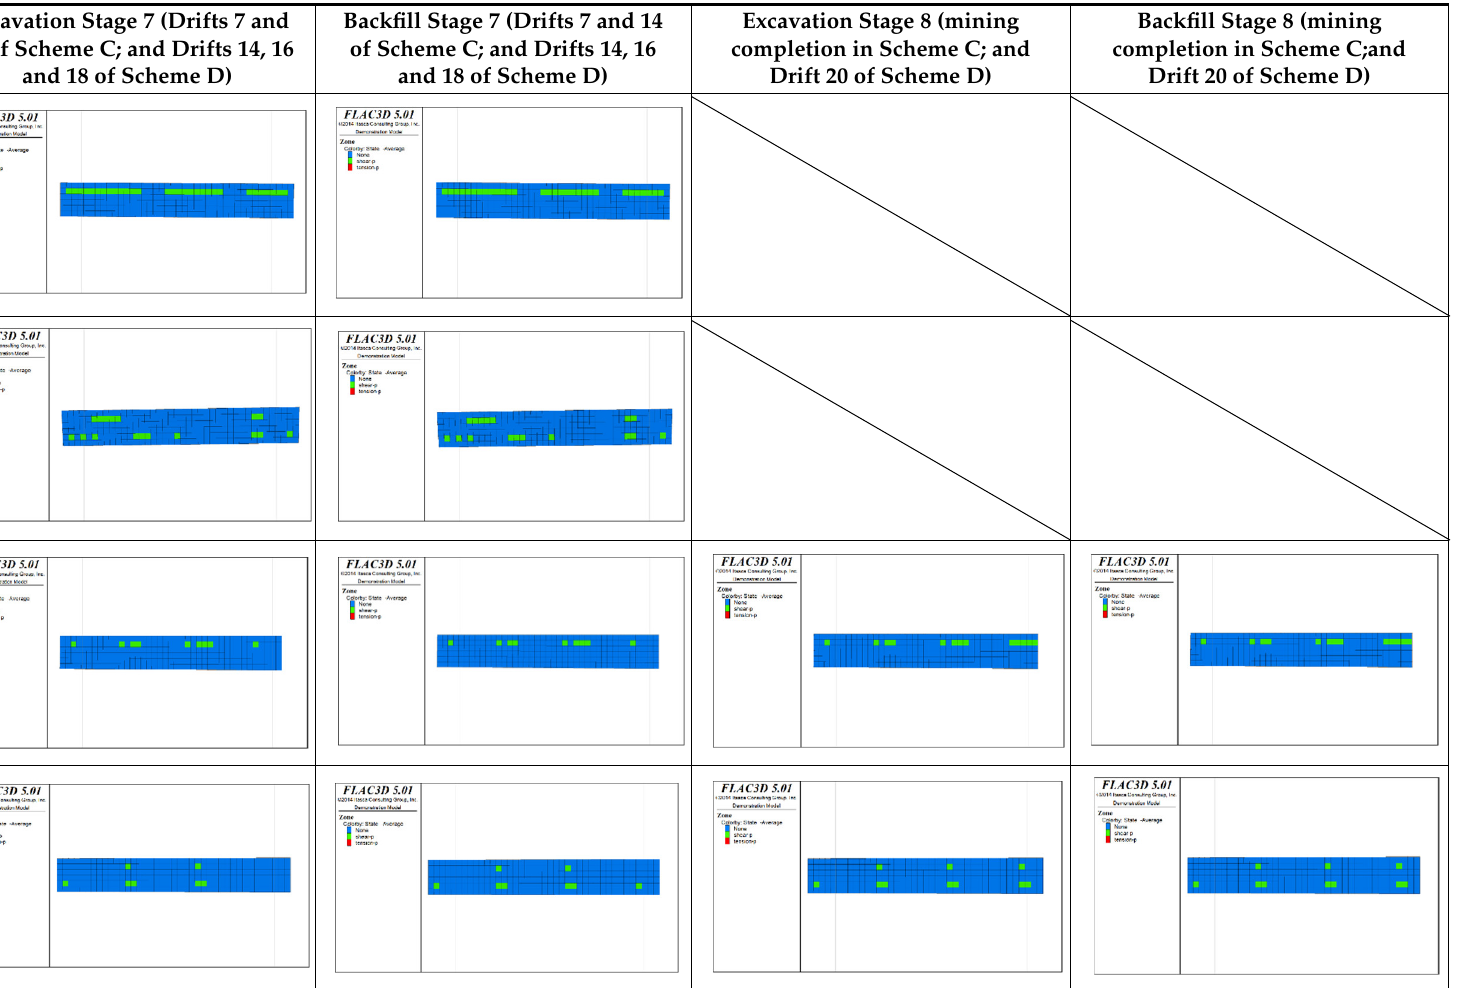
Table 9. Distributions of roof protection layer plastic zones under Schemes C and D (excavation stages 7 and 8).